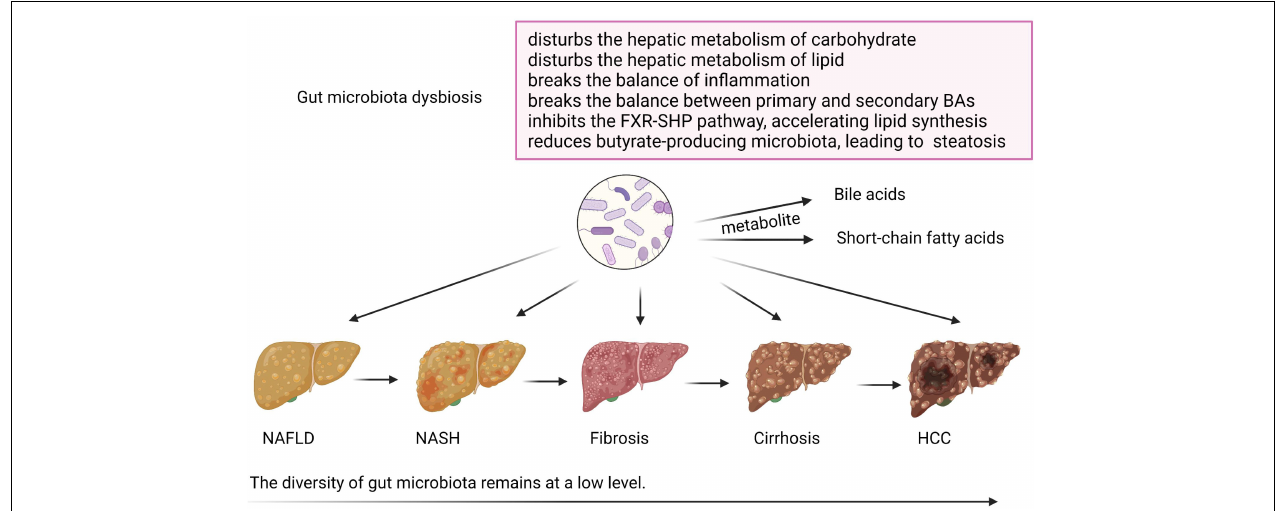
FIGURE 2 | The role of gut microbiota dysbiosis in non-alcoholic fatty liver disease (NAFLD) and its advanced disease progression. During the progression of NAFLD, the diversity of gut microbiota remains at a low level. Gut microbiota dysbiosis disturbs the hepatic metabolism of carbohydrates and lipids and breaks the balance of inflammation. Disturbed gut microbiota also changes the normal metabolism of bile acids (BAs) and short-chain fatty acids, and may cause NAFLD via breaking the balance between primary and secondary BAs, inhibiting the FXR-SHP pathway, which accelerates lipid synthesis, and reducing butyrate-producing microbiota, which causes steatosis. Created with